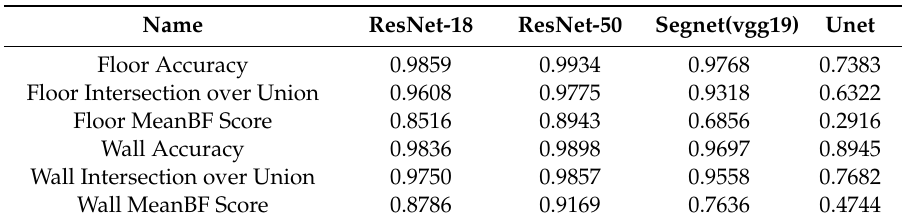
Table 3. Di ff erent network accuracy comparison.